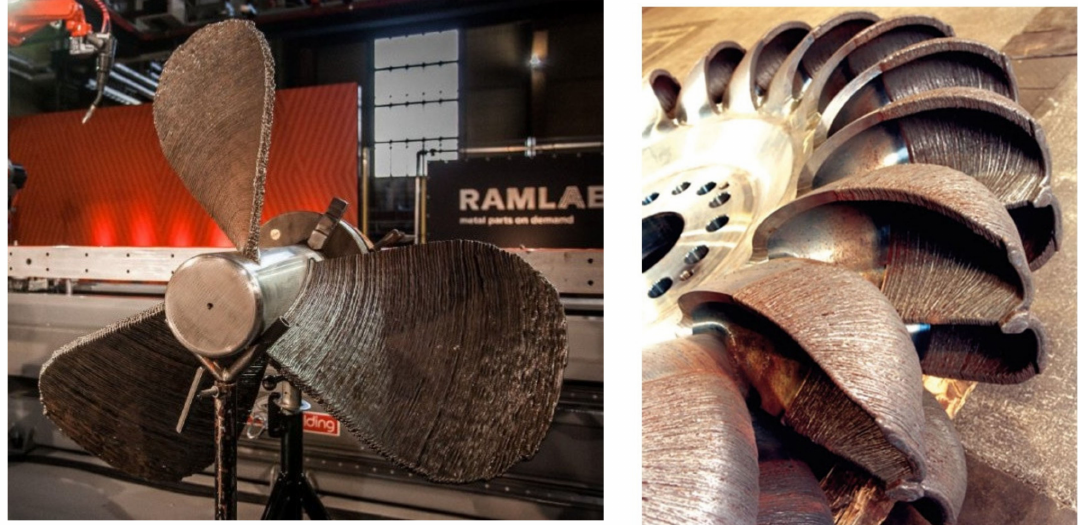
Figure 4. ( Left ) WAAM-manufactured propeller (Ramlab) ( Right ) WAAM-manufactured water turbine blades (Hydroworld)